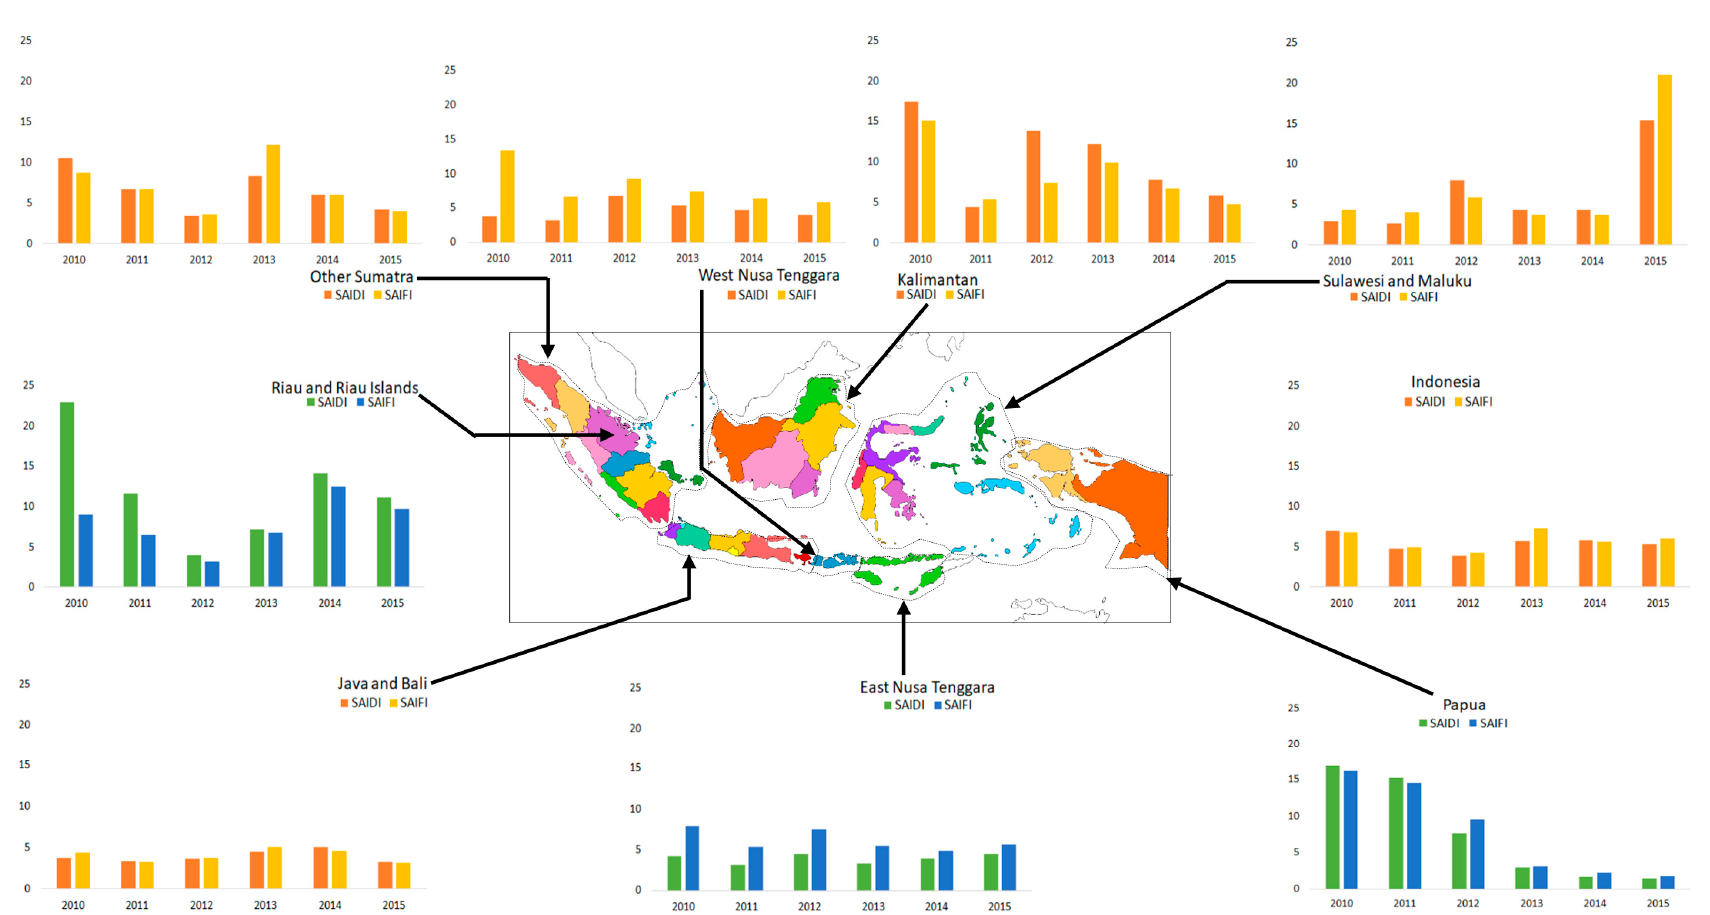
Figure 3. SAIDI in hours of outage per customer per year and SAIFI in a number of outage events per customer per year for various locations in Indonesia for 2010 to 2015. Data sources: PLN (2011–2016) [2,48–52].